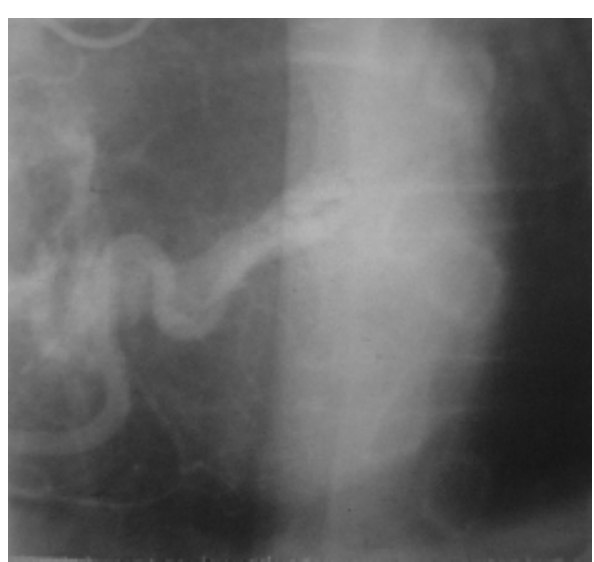
Fig. 1 – Coronariografia do caso 1 mostrando artéria coronária direita dilatada e tortuosa comunicando-se com o ventrículo direito.